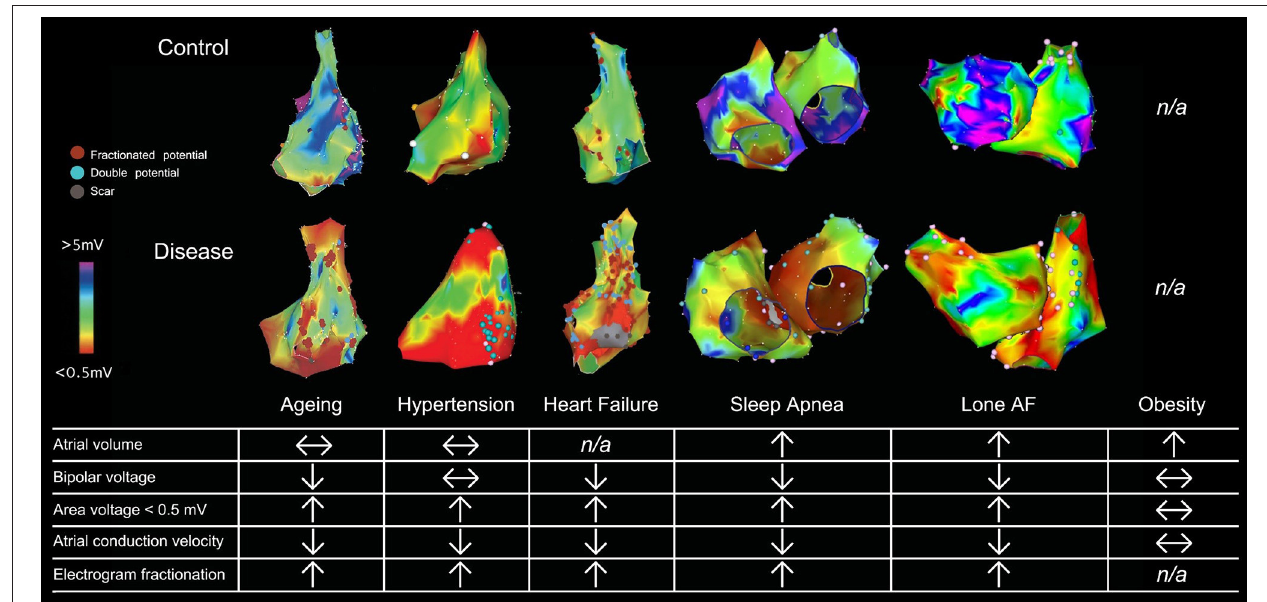
FIGURE 1 | Electroanatomical maps and electrophysiological changes in various AF substrates. 3-D electroanatomical maps from various AF substrates are shown with bipolar voltage scaled from < 0.05mV (red) to > 5mV (purple). Points with fractionated or double potentials or scar are annotated with red, blue, and gray dots respectively. Figure used by permission from Lau et al. (2017) © American Heart